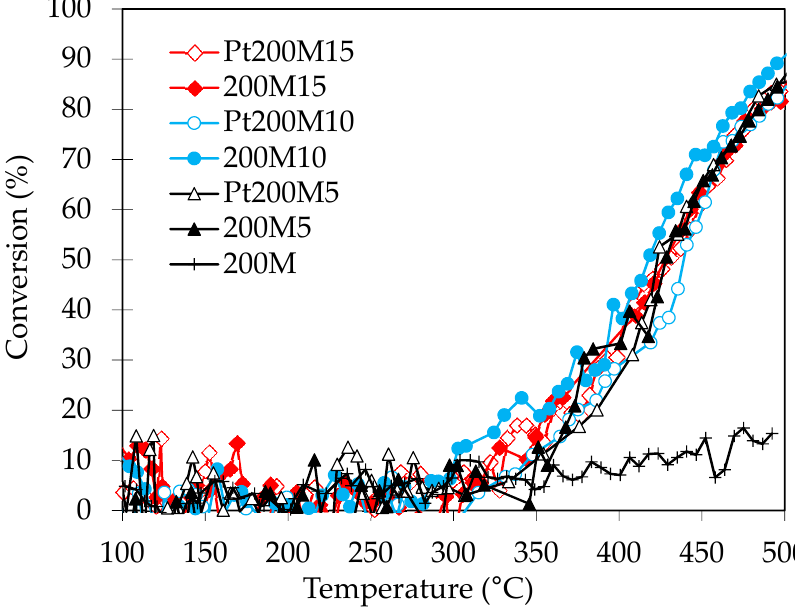
Figure 6. Light-off curves for DCM oxidation over monolith catalysts with 200 cpsi. (Experimental conditions: DCM 500 ppm, GHSV 30,556 h − 1 (1.2 L min − 1 ), H 2 O 1.5 vol %) In the Figure 200M is the cordierite substrate alone and 200Mx (x = 5, 10, 15) is the coated monolith where x is the loading of silica on alumina.